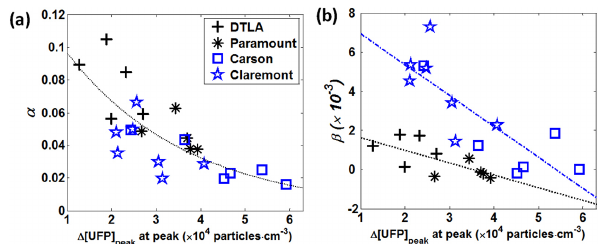
Figure 5. Variations in dispersion coefficients as a function of wind speed. (a) α vs. vector-averaged resultant wind speeds. (b) β vs. scalar-averaged wind speeds. Black solid line is a linear fit for the DTLA data points, black dotted line for Paramount, and blue dash- dotted line for Carson and Claremont. Vertical dotted line in (b) rep- resents scalar wind speed of 0.5ms − 1 . Light blue star denotes Claremont data obtained on 8 June 2011 when wind was strong with reversed prevailing wind direction and fogs in the uphill downwind area.